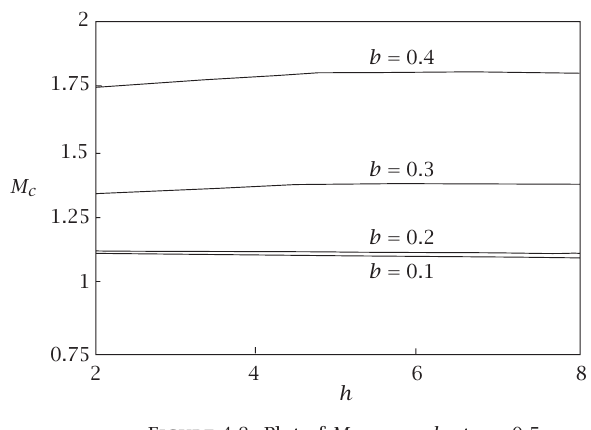
Figure 4.7 . Plot of M